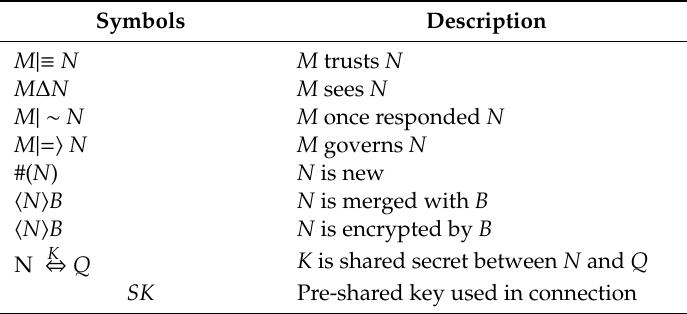
Table 3. Symbols used in the BAN (Burrows Abadi Nadeem) logic. Symbols